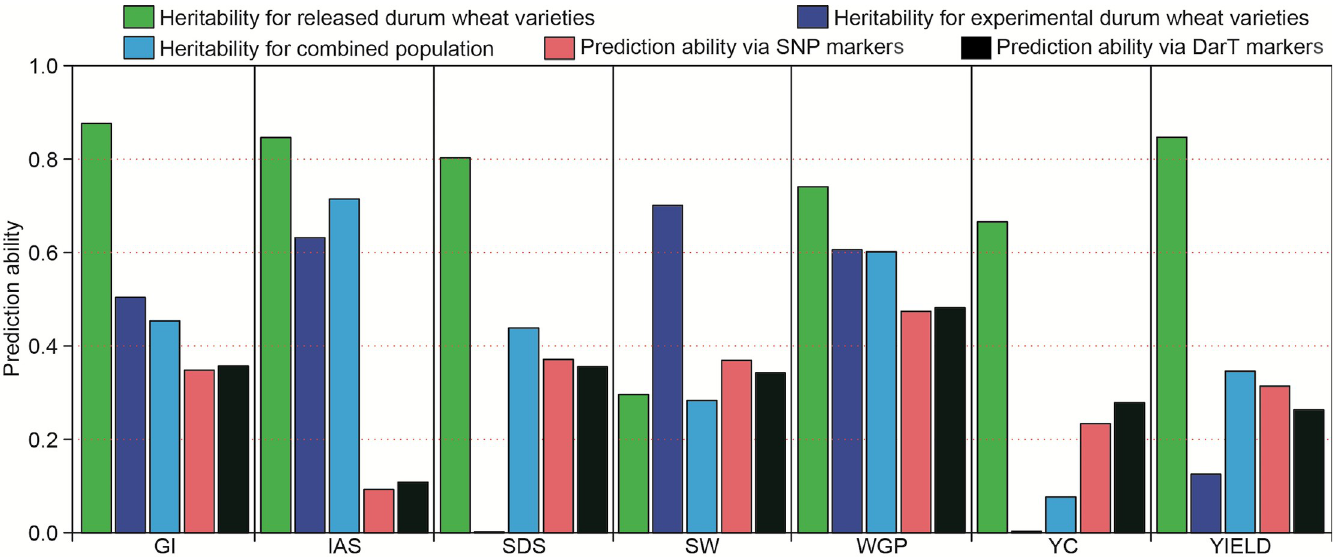
Fig 6. Genomic selection and heritability. a) Genomic selection accuracies for 179 lines using SNP and DArT markers for the assessed traits. b) Relationship between prediction ability and heritability. GI: gluten index; IAS: initial agronomic score; SDS: sedimentation index; SW: specific weight; WGP: whole grain protein; YC: yellow colour; and YIELD: grain yield.